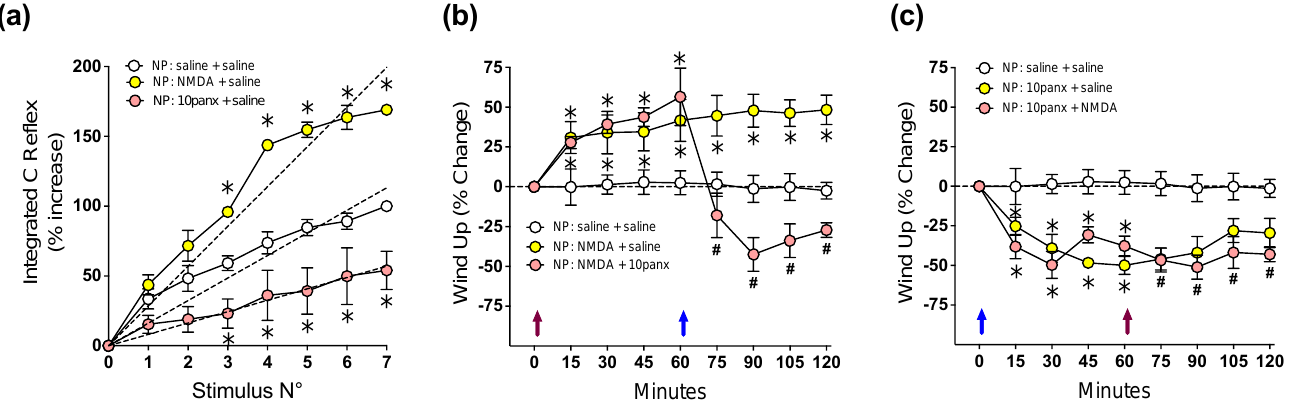
Figure 2. Effect of intrathecal administration of NMDA followed by 10panx, or 10panx followed by NMDA, on C-reflex wind-up activity of neuropathic (NP) rats. NP rats receiving saline served as controls. Values are means ± SEM, n = 6 rats in each group. ( a ) Figure depicting data processing for determining spinal cord wind-up scores in neuropathic animals. C-reflex responses were elicited by repetitive electric stimulation (1 Hz) of the second and third toes to develop wind-up potentiation, a frequency-dependent increase in the excitability of spinal cord neurons. The C-reflex responses were integrated and plotted against the stimulus number, and the curves were normalized so that the reflex gain at the seventh stimulus represented a 100% increase. The slope of the least-squares regression line represents a control wind-up score, prior to any administration of drugs or saline. Thereafter, a 10 µL i.t. injection of either saline solution (white circles), 2 mM NMDA (yellow circles) or 300 µM 10panx (pink circles) was performed, and a new series of seven repetitive electric stimulations (1 Hz) was applied 30 min after, and the wind-up scores calculated from the slopes of the respective least-squares regression lines. The procedure was repeated using 6 animals per group, and the average data is presented as Figure a. Values are means ± SEM of data averaged from 6 rats per group, and the slopes of regression curves (dashed lines) represent wind-up scores obtained 30 min after each drug treatment: 16.15 ± 0.70 (saline), 28.48 ± 0.99 * (NMDA), and 8.14 ± 0.95* (10panx), the difference between slopes being statistically significant (one-way ANOVA, F 2,15 = 132.7; * p at least <0.0001 with respect to saline group, Bonferroni multiple comparisons test). ( b ) Time course of wind-up activity (expressed as % change) in neuropathic rats immediately before and 15, 30, 45, 60, 75, 90, 105, and 120 min after an i.t. injection of NMDA or saline at time 0 (violet arrow), followed by an i.t. injection of 10panx or saline at time 60 min (blue arrow). Two-way repeated measures ANOVA revealed a “time” effect (F 1.732,29.44 = 4.504). Intragroup analysis: * p at least <0.05 with respect to time zero min, # p at least <0.05 with respect to time 60 min, Bonferroni multiple comparisons test). Note the increased wind-up activity after MDMA, and the counteracting effect